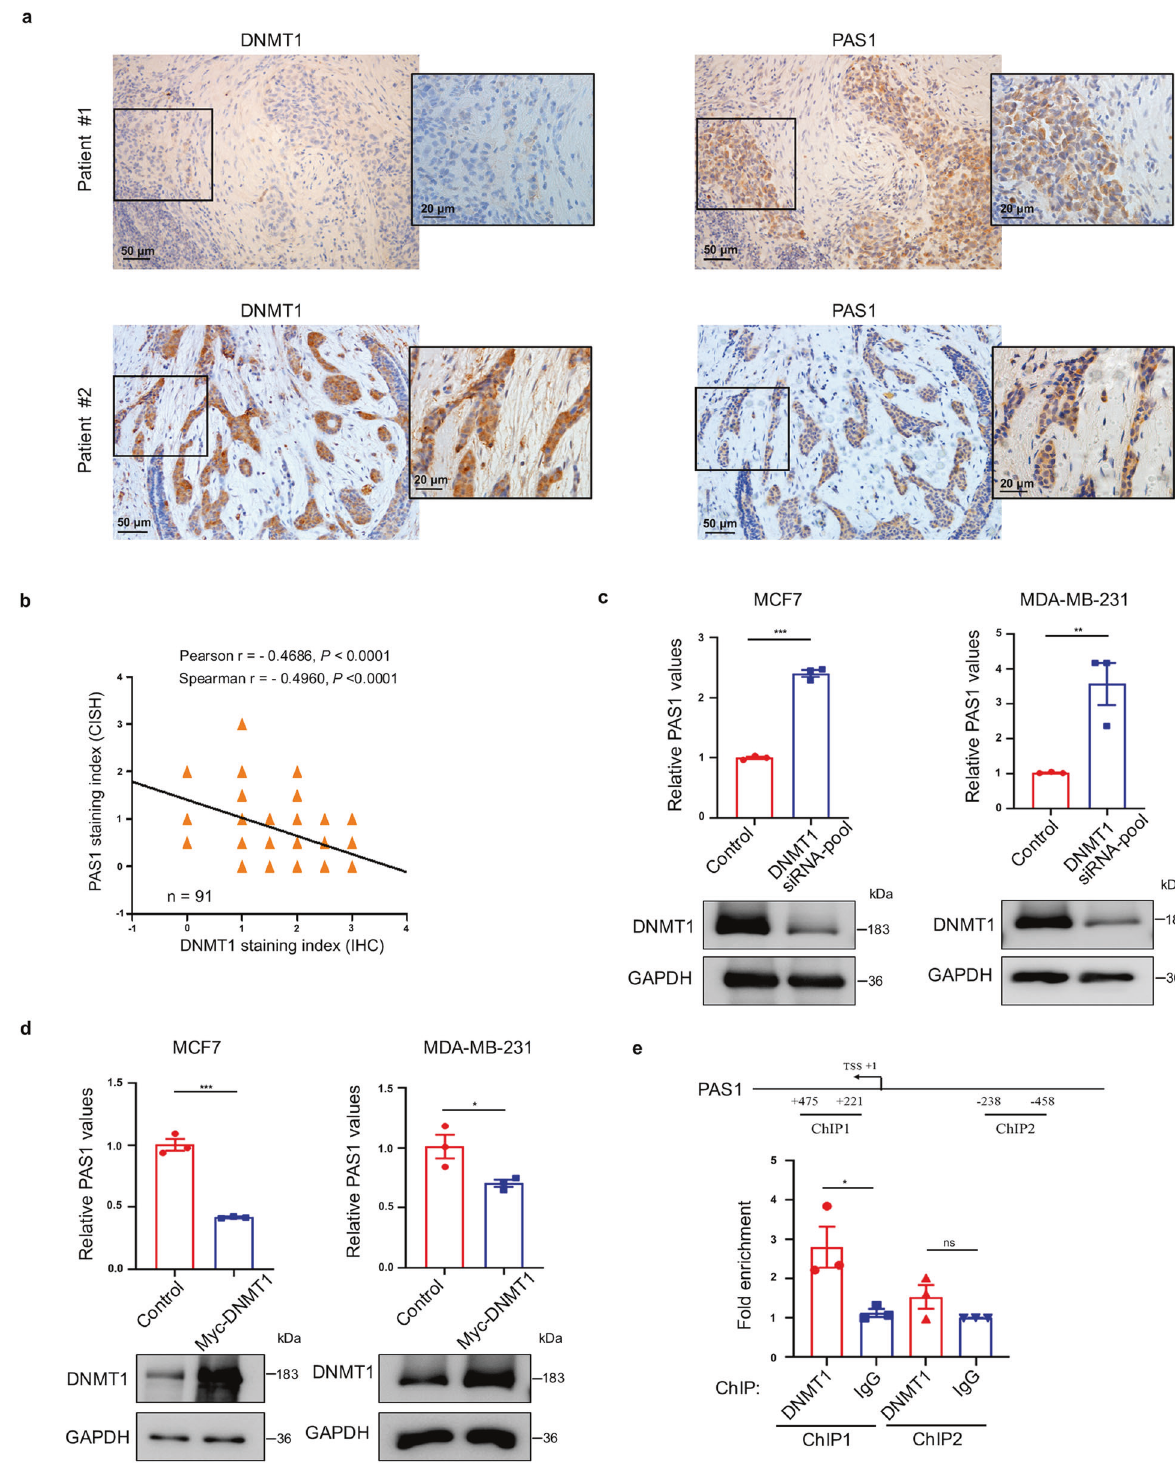
Fig. 2 DNMT1 suppresses PAS1 expression. a , b Both PAS1 expression (chromogenic in situ hybridization, CISH) and DNMT1 expression (immunohistochemistry, IHC) were examined in paraf fi n-embedded tissues of 91 breast cancer patients. Representative images are shown in ( a ). Pearson and Spearman correlation tests were performed in ( b ). c Control and DNMT1 siRNAs pool was transfected, followed qRT-PCR and Western blot analysis. d Empty vector or Myc-DNMT1 was transfected, followed qRT-PCR and Western blot analysis. e Schematic representations of the region used for PAS1 ChIP assay. Lysates of Hs578T cells were extracted for ChIP assays using anti-DNMT1 antibodies. Q-PCR assays were performed to quantify ChIP-enriched DNAs. Data in c – e are mean ± SEM from three experiments by two-tailed t test. * p < 0.05, ** p < 0.01, *** p < 0.001